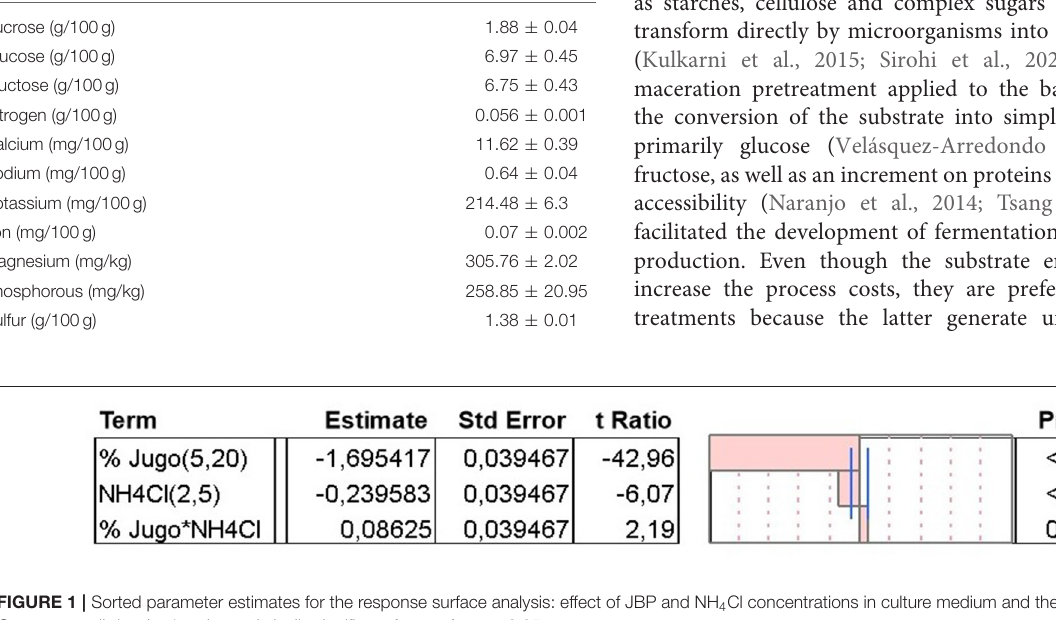
Frontiers in Sustainable Food Systems |